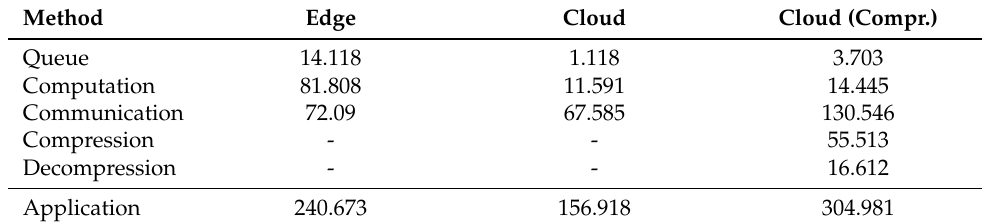
Table 2. Mean latencies in milliseconds of three experiments with batch size 128.